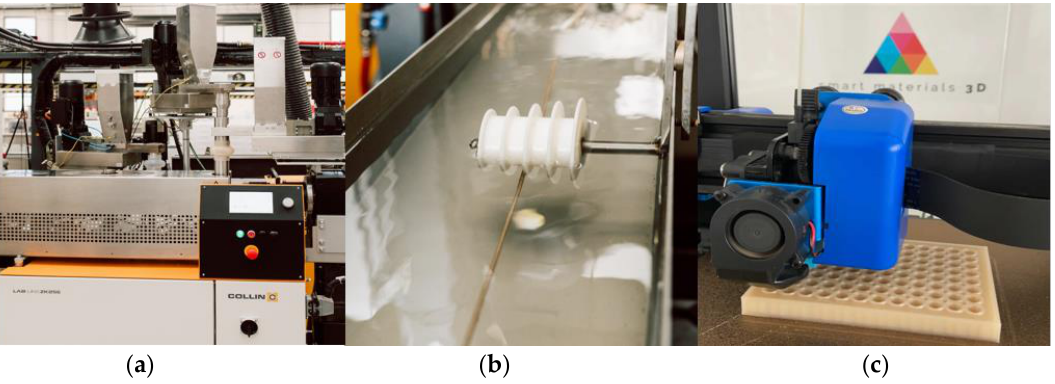
Table 1. 3D-Printing process settings for Artillery GENIUS printer.